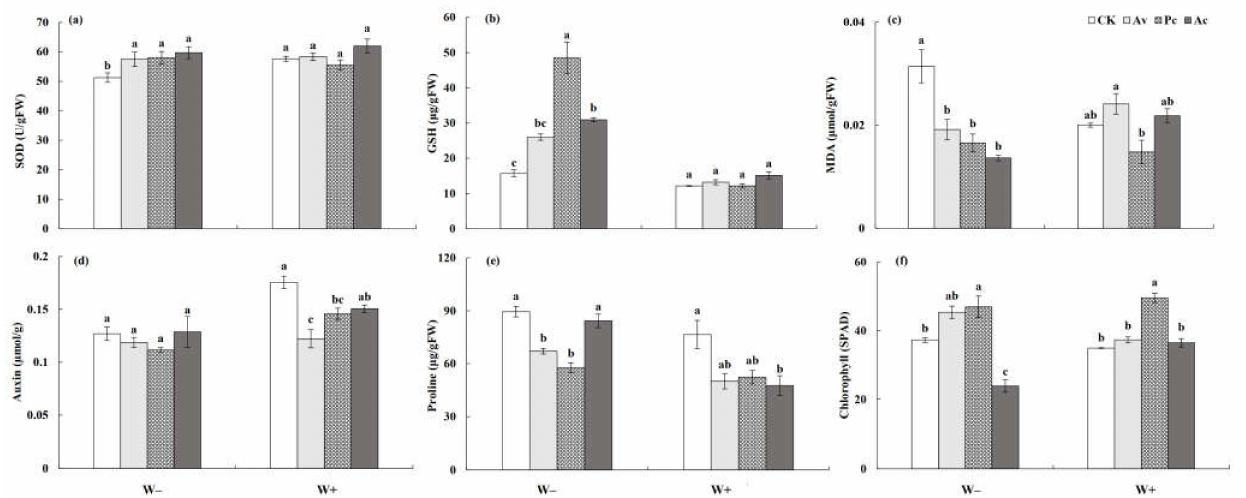
Figure 12. Effects of dark septate endophyte (DSE) on the shoot and root physiological traits of Artemisia ordosica seedlings under drought stress. Different letters above the error bars indicate a significant difference at p < 0.05. Note: ( a ), SOD, ( b ), GSH, ( c ), MDA, ( d ), auxin, ( e ) proline, ( f ), chlorophyll. W − , drought treatment. W+, well-watered treatment. CK, non-DSE inoculated control. Ac, Pc, and Av, plants inoculated with Alternaria chartarum , Paraphoma chrysanthemicola , and Acrocalymma vagum